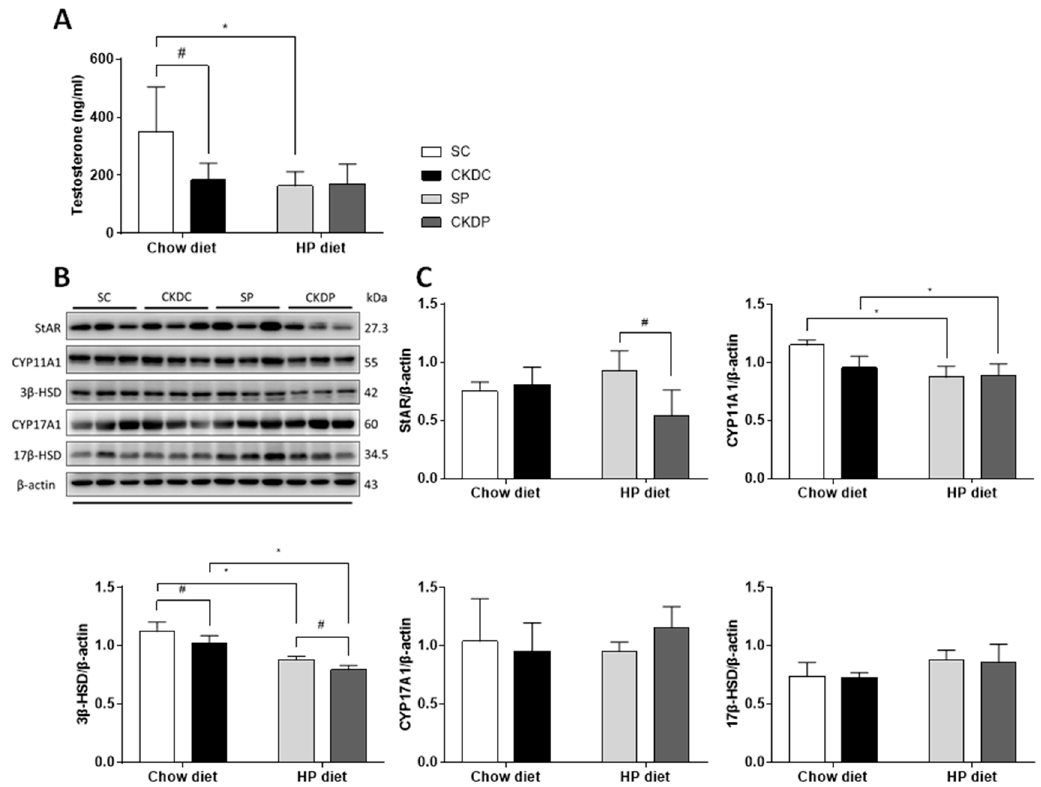
Figure 4. Testicular testosterone levels and protein expressions of testosterone biosynthesis markers Figure 4. ( A ) Testicular testosterone levels and ( B ) protein expressions of testosterone biosynthesis in high phosphorus diet-fed mice with or without CKD induction. ( A ) Testicular testosterone levels; enzymes (StAR, CYP11A1, 3 β -HSD, CYP17A1, and 17 β -HSD) in high phosphorus diet-fed mice with ( B ) testosterone biosynthesis enzymes (StAR, CYP11A1, 3 β -HSD, CYP17A1, and 17 β -HSD) and ( C ) or without CKD induction. (C) relative density analysis of the protein bands. Data are expressed as relative density analysis of the protein bands. Data are expressed as the mean ± SD. # indicates a the mean ± SD. # indicates a significant difference between the sham-operated and CKD-induced significant di ff erence between the sham-operated and CKD-induced groups (SC vs. CKDC and SP vs. groups (SC vs. CKDC and SP vs. CKDP); * indicates a significant difference between the chow diet CKDP); * indicates a significant di ff erence between the chow diet and high phosphorus diet groups (SC and high phosphorus diet groups (SC vs. SP and CKDC vs. CKDP) . vs. SP and CKDC vs.